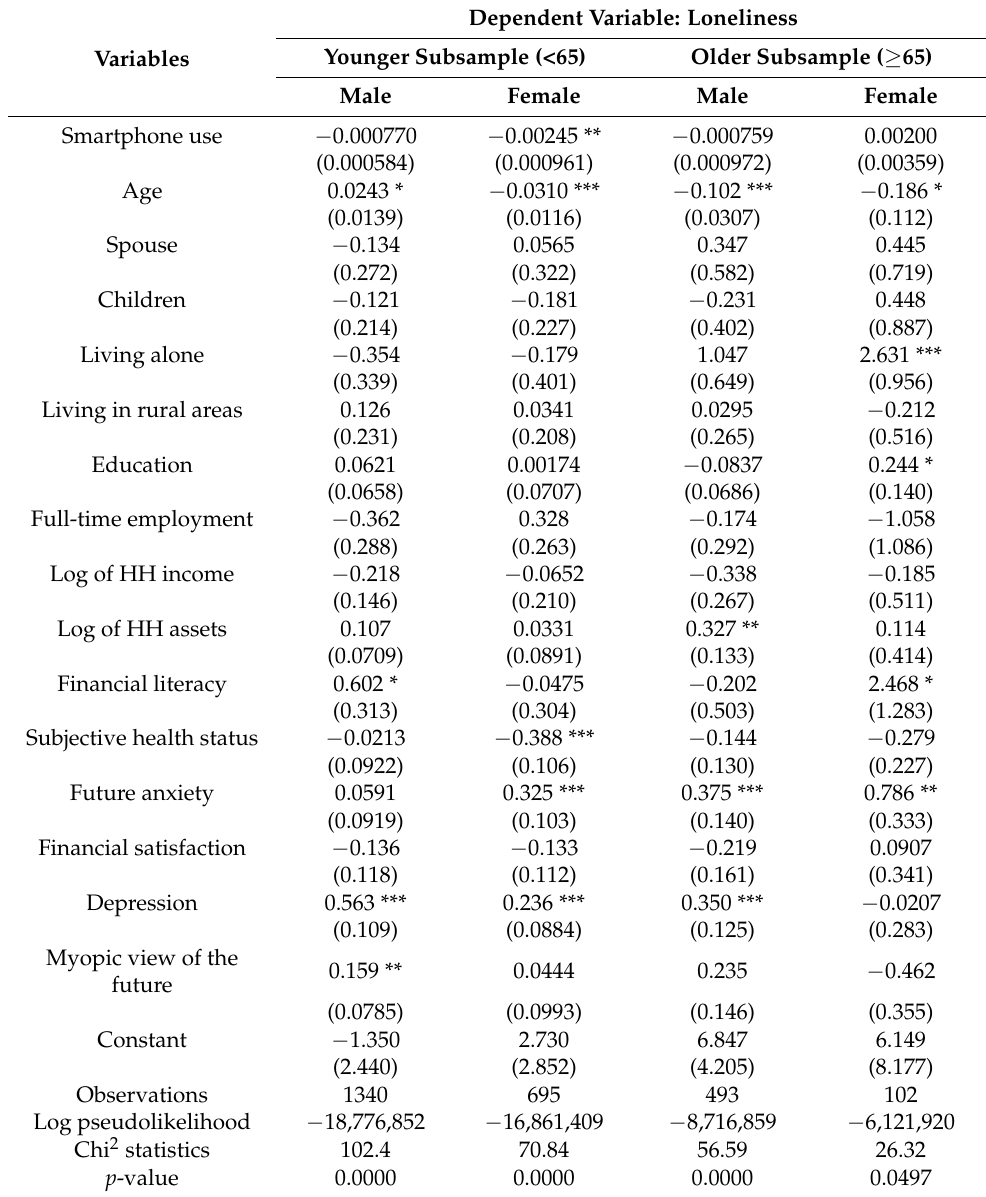
Table 5. Logit regression results of loneliness in 2022 (subsample analysis by gender and age